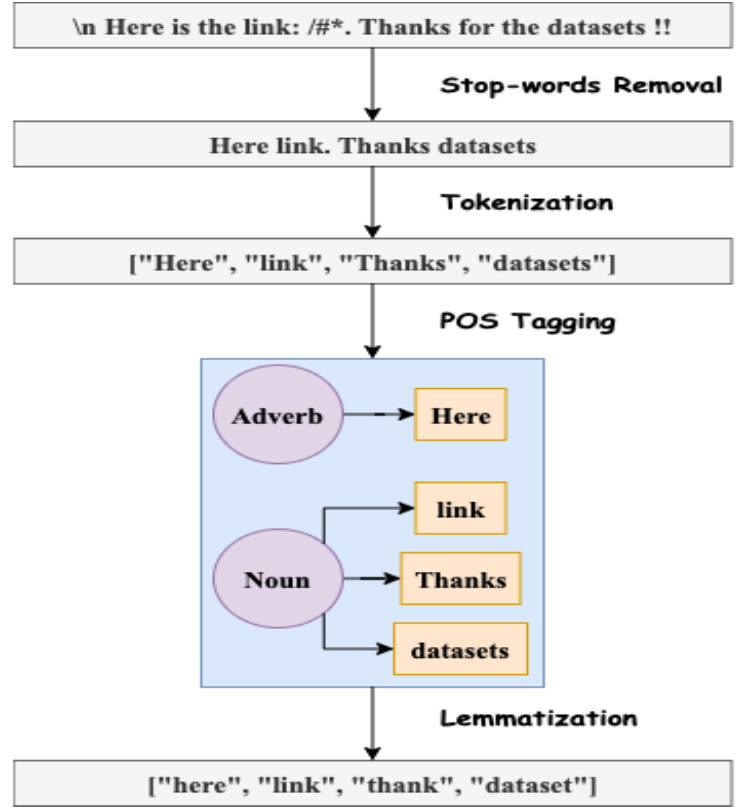
Figure 2. Text preprocessing phase.